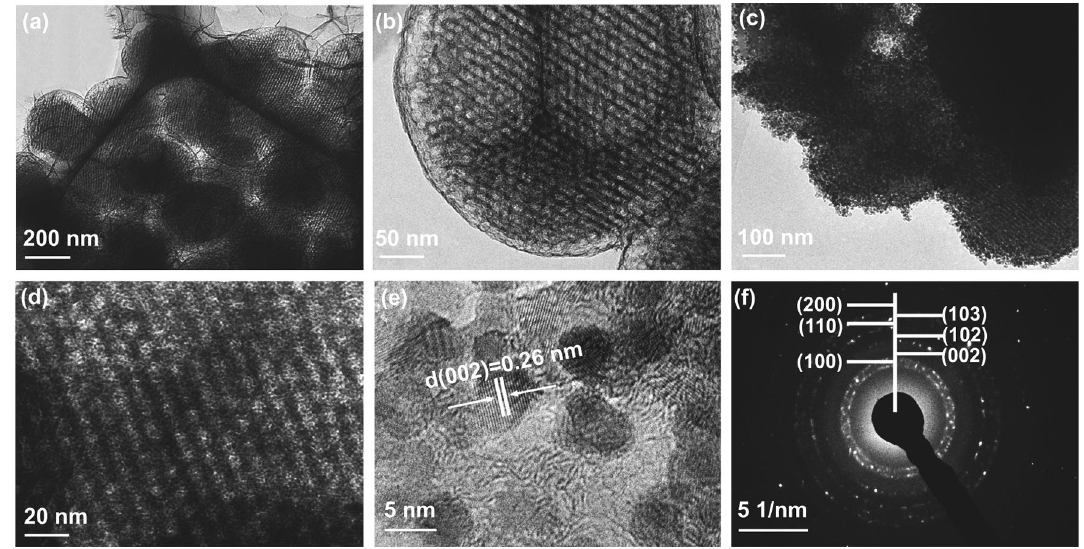
Fig. 2 a, b TEM images of OMCS with different magnifications. c, d TEM images of ZnO/OMCS-40 with different magnifications. e HR-TEM image of ZnO/OMCS-40. f The corresponding SAED pattern of